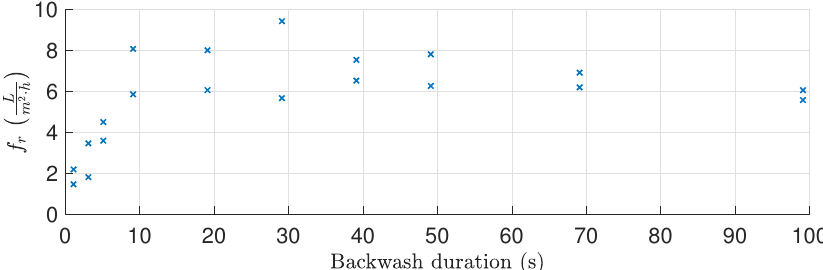
Figure 6. Flux recovered as a function of backwashing duration as defined in Equation (5), based on the data illustrated in Figure